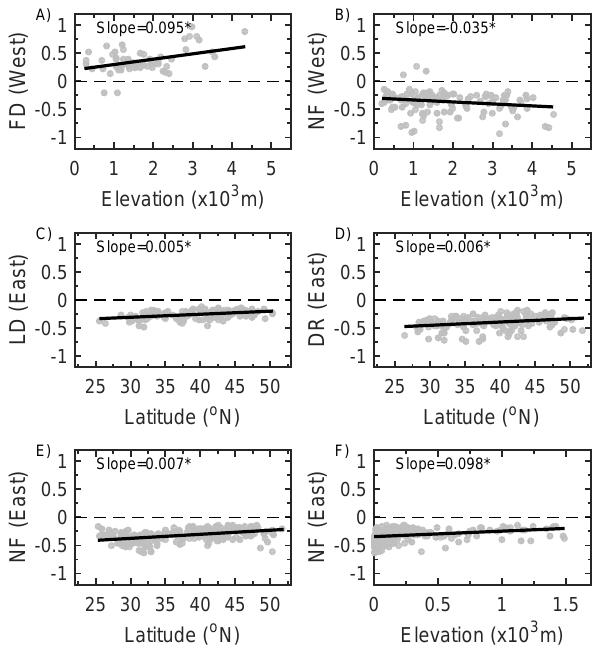
Figure 7. Trends of the first date (FD), the last date (LD), dura- tion (DR), and number of freeze days (NF) at stations in western China (in first row, longitude ≤ 110 ◦ E) and in eastern China (in sec- ond and third rows, longitude > 110 ◦ E) against latitude ( ◦ N) and elevation ( × 10 3 ma.s.l.). Each point represents one station, with a statistically confidential level of 95% or higher. Solid cycles are data points, and lines are linear fitted lines. Asterisk indicates a sig- nificant trend at the 95% confidential level or higher.